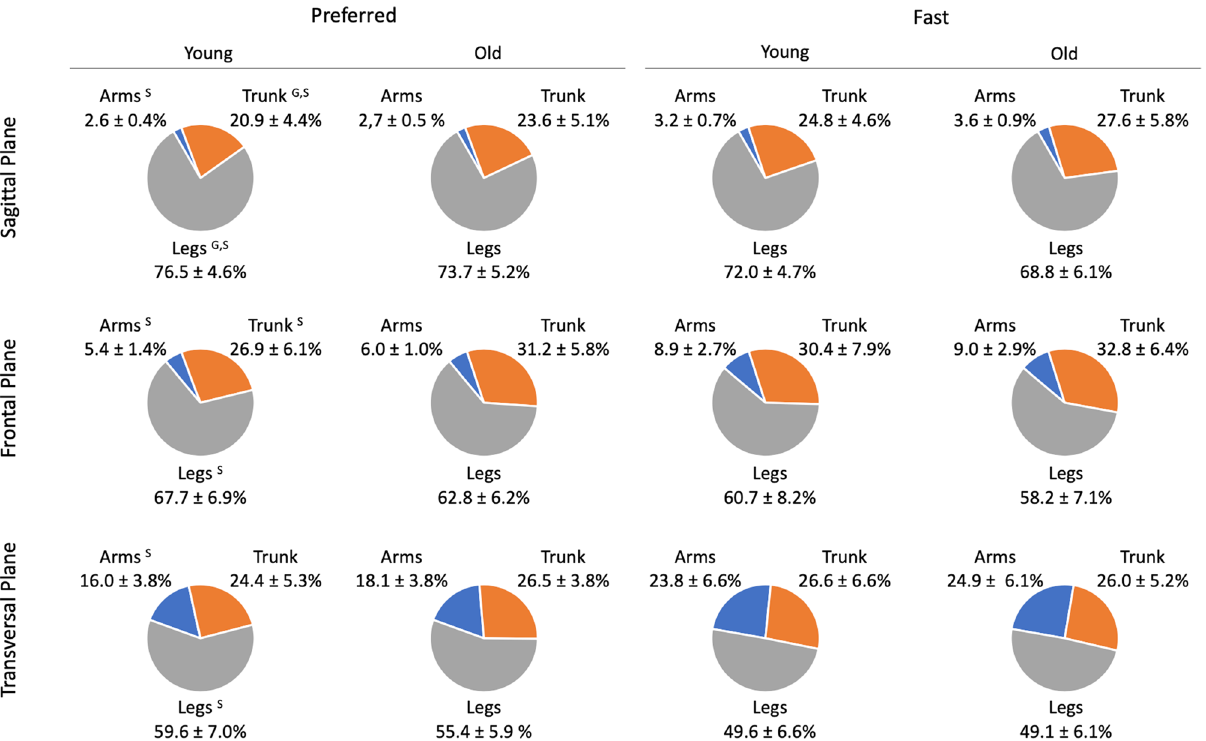
Figure 5. Mean values of the contribution to total absolute H (%) of the trunk, legs and arms in the sagittal, frontal and transversal planes. Relative contributions of the segments were averaged over the total duration of the stepping movement. ‘G’ indicated significant differences between old and young individuals. ‘S’ indicated significant differences between the preferred and fast speed conditions.